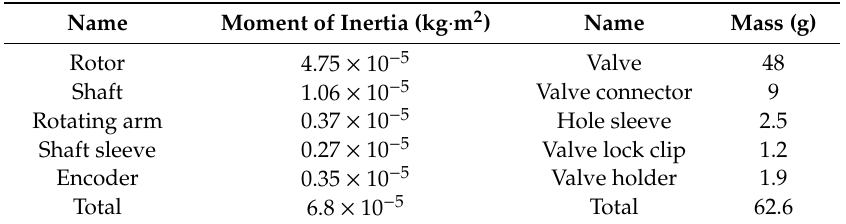
Table 2. Main parameters of the actuator.